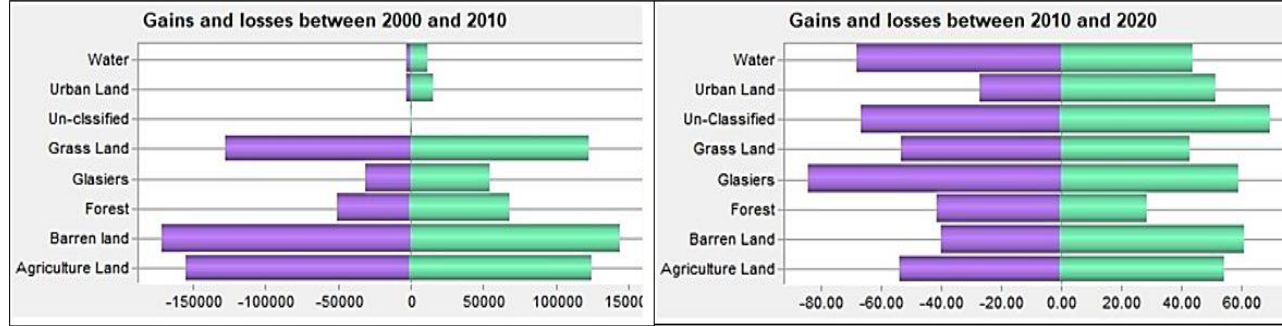
Figure 5. Contribution to Net change of LULC class of the study periods